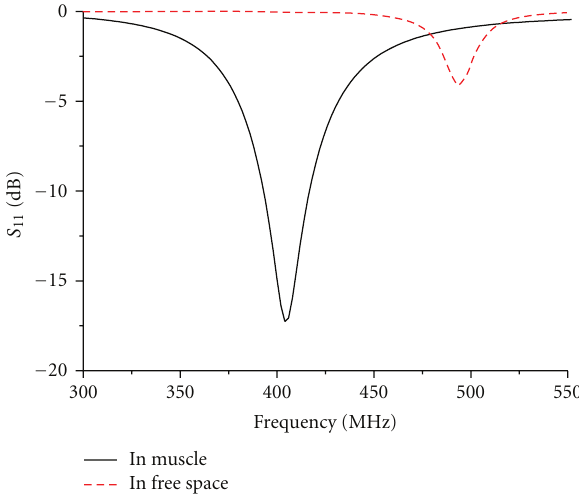
Figure 3: Simulated reflection coe ffi cients in 2/3 human muscle block and in free space.